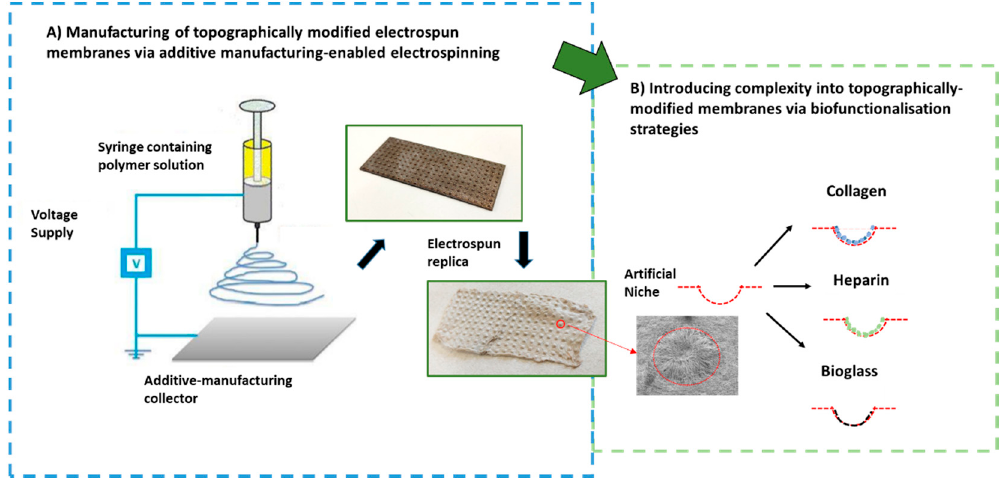
Figure 2. Schematic highlighting the manufacturing approach undertaken to develop the topographically controlled electrospun substrates and summary of chosen biofunctionalization strategies to modify the electrospun niche-like